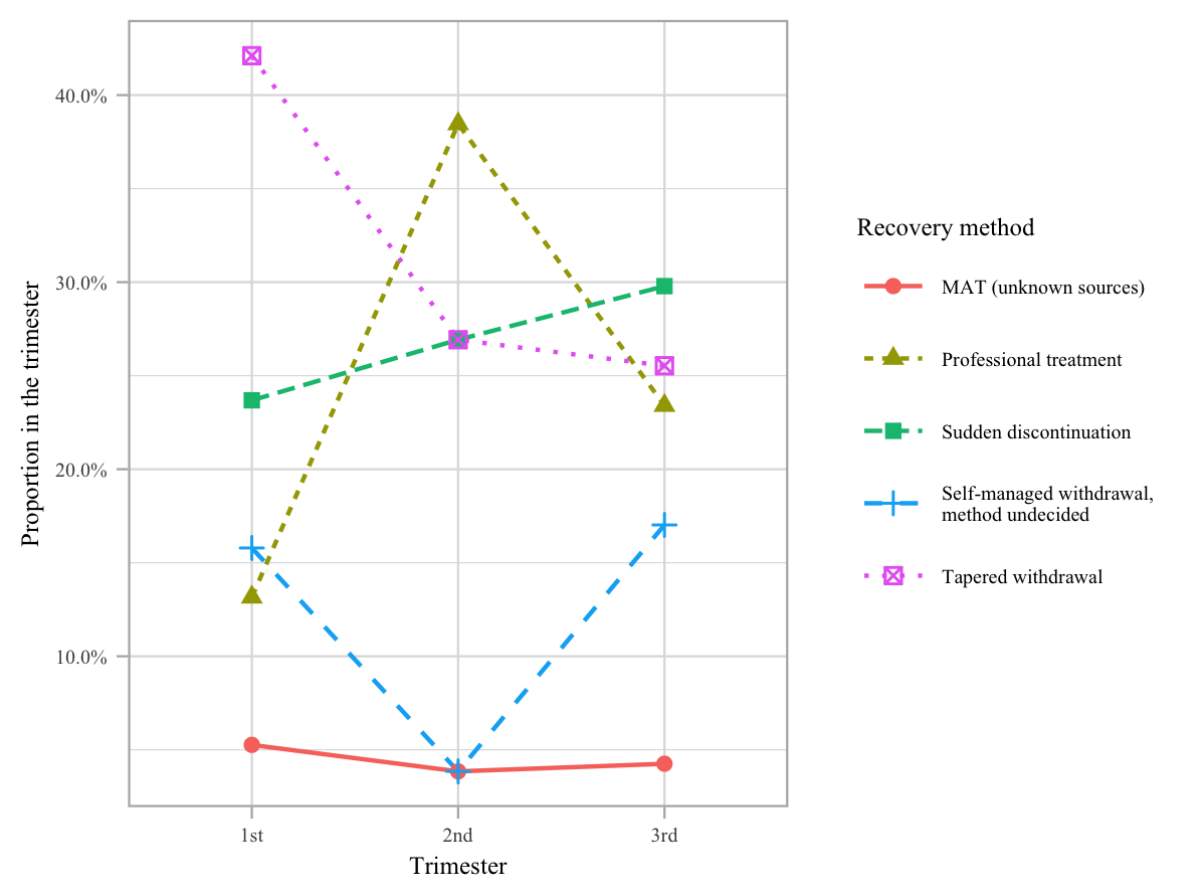
Figure 3. Proportions of the recovery methods by